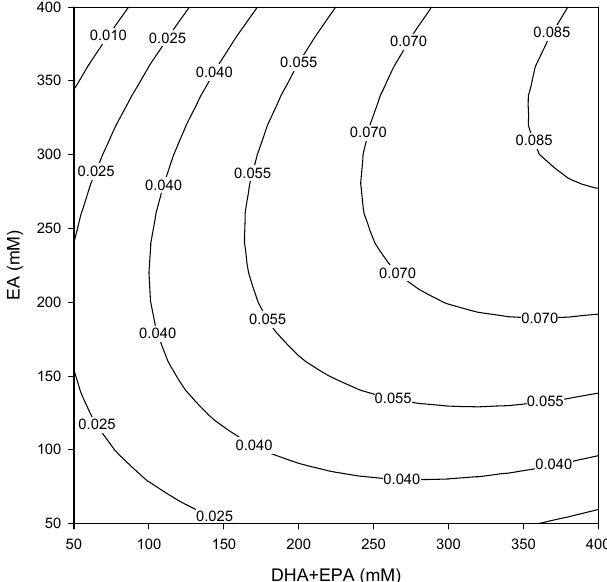
Figure 1. Contour plot showing the initial rate of DHA + EPA ethyl ester production at varying concentrations of DHA + EPA (mM) and EA (mM). Numbers on contours denote initial rate ( μ mol min − 1 U − 1 ) under given reaction conditions.